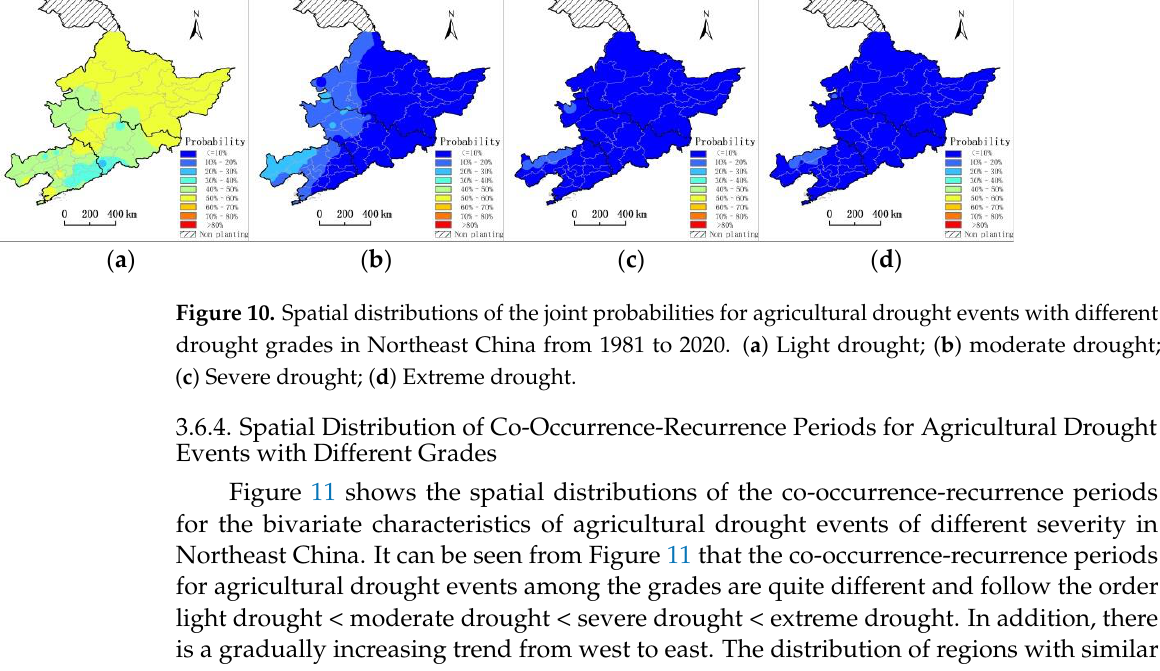
Figure 9. Spatial distributions of the agricultural drought event joint probabilities and the co-occurrence recurrence periods in Northeast China from 1981 to 2020. ( a ) Probability; ( b ):recurrence period.